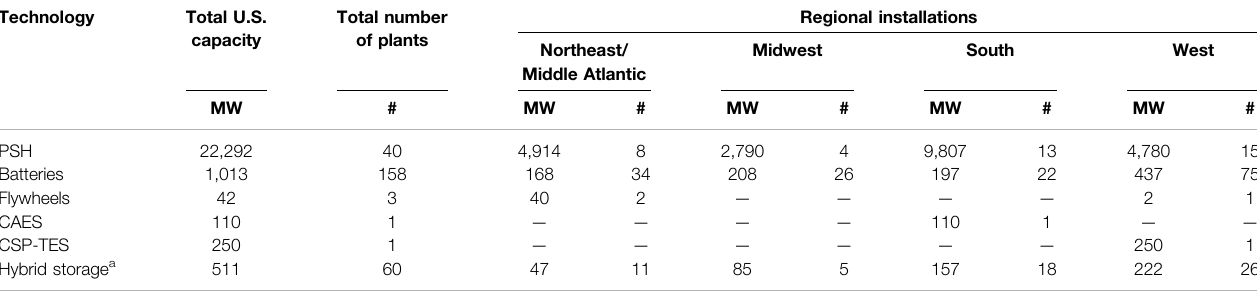
TABLE 1 | Distribution of energy storage in operations as electric power resources by United States region, September 2019.